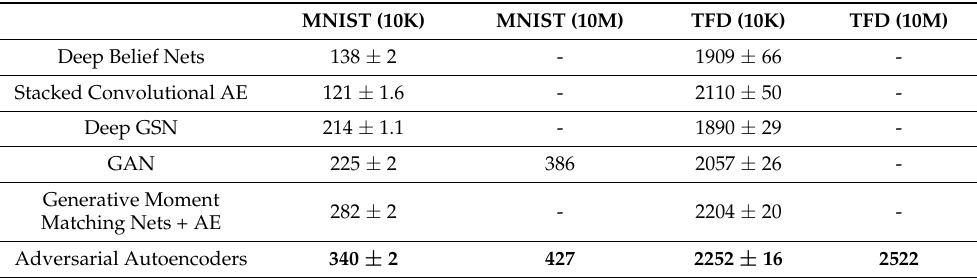
Table 5. Results on Window estimate obtained in